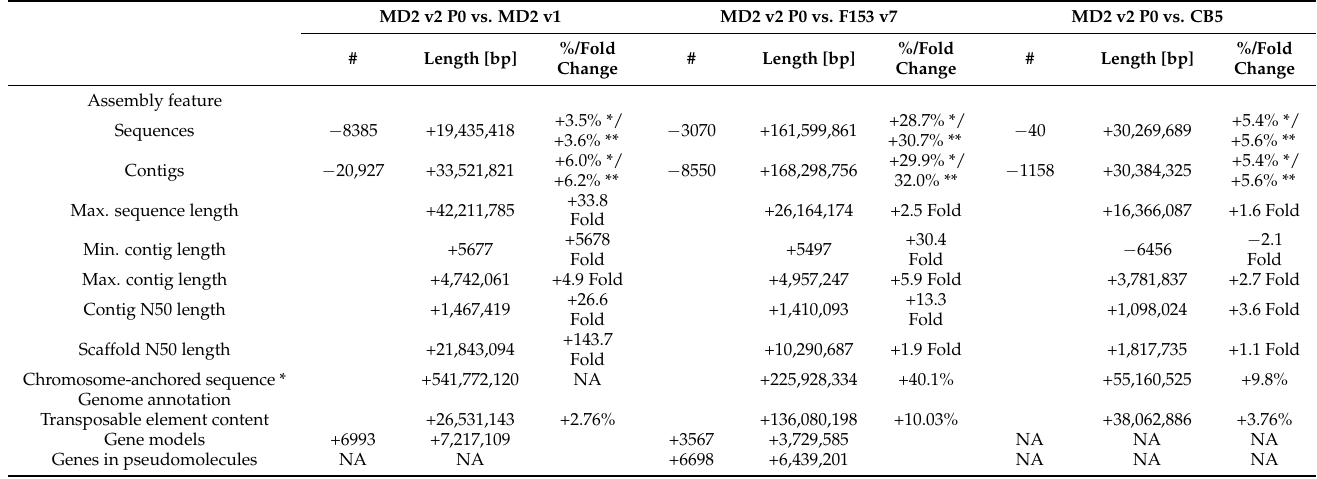
Table 2. Assembly statistical comparisons between MD2 v2 and publicly available pineapple